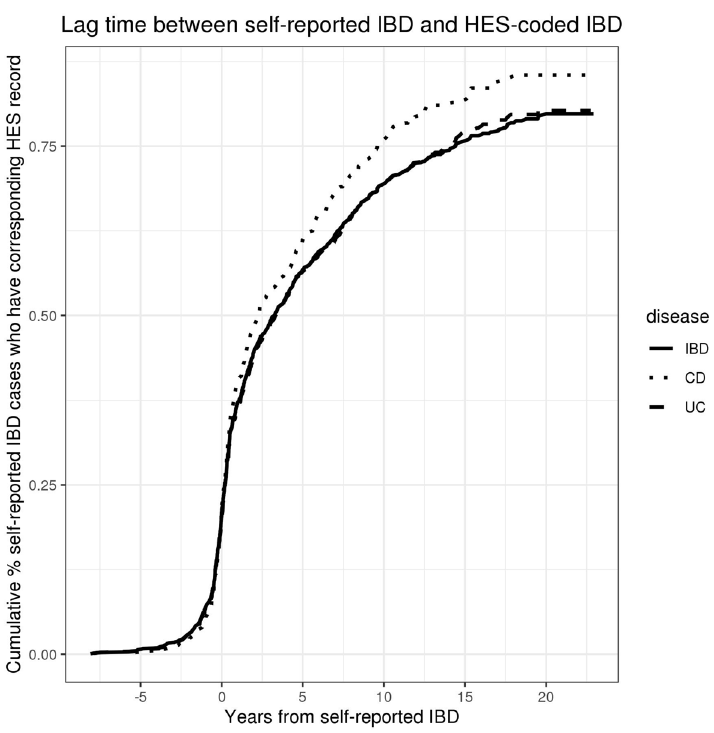
Figure 2. Lag time between self-reported IBD and HES-coded IBD for patients self-reporting IBD after 1997, measured by number of years from earliest recollection of first diagnosis to first instance of relevant ICD10-code in HES